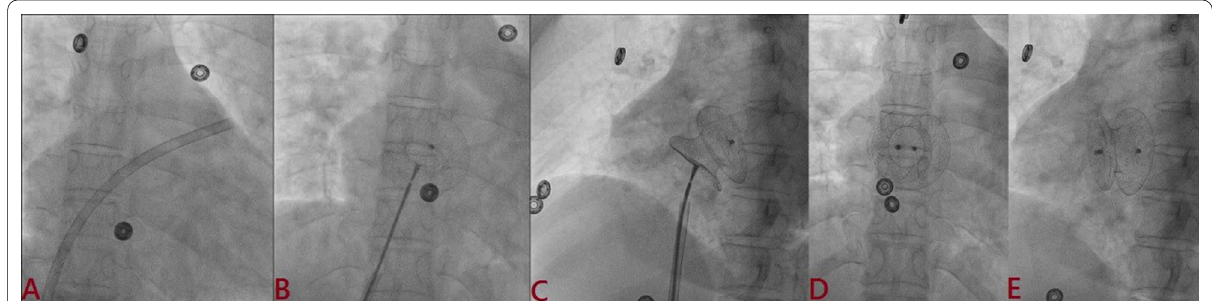
Fig. 4 Device deployment using LUPV technique. ( A Delivery sheath positioned in LUPV; B LA disk of device was uncovered and once got snugly fit, RA disk of device was released by gradually pulling the sheath further; C Minnesota maneuver was performed to ensure properly sitting disks across defect; D device position on AP view; E device position on LAO